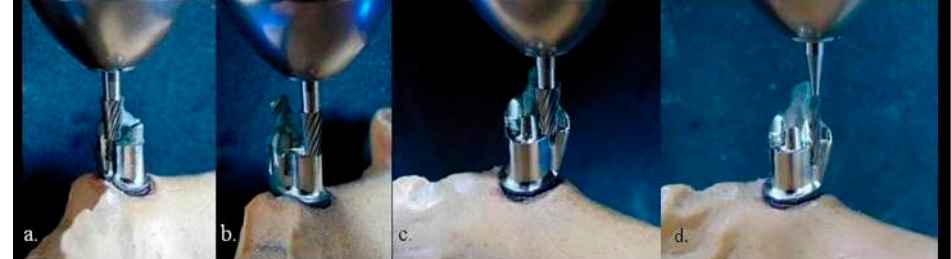
Figure 3. ( a – c ). Milling of the shoulder m (different perspectives); ( d ). Bilateral milling of vertical wells.